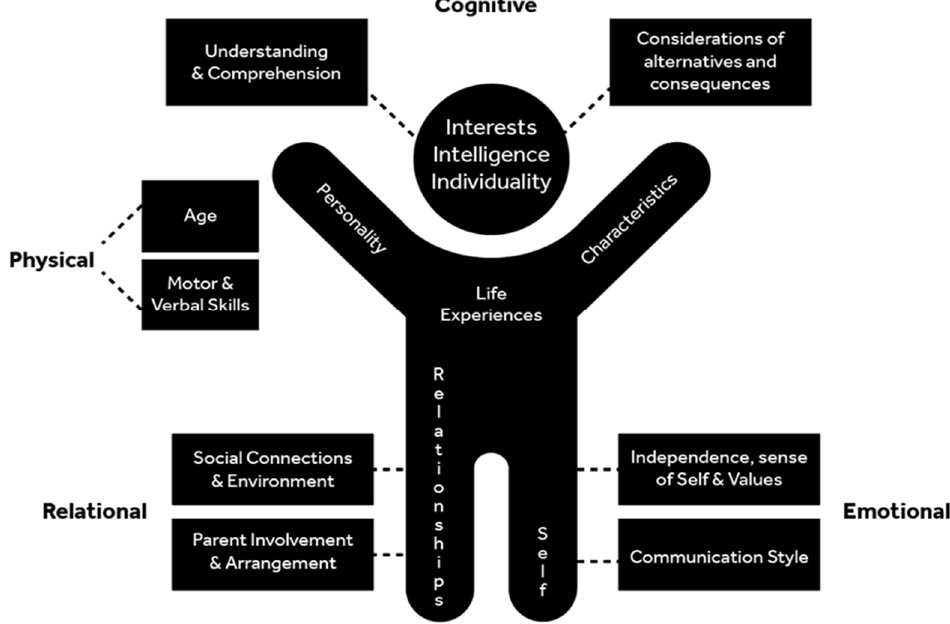
Figure 1. A visual comprehension of the complex capacity of a child. Table 1. Main domains and elements of children’s